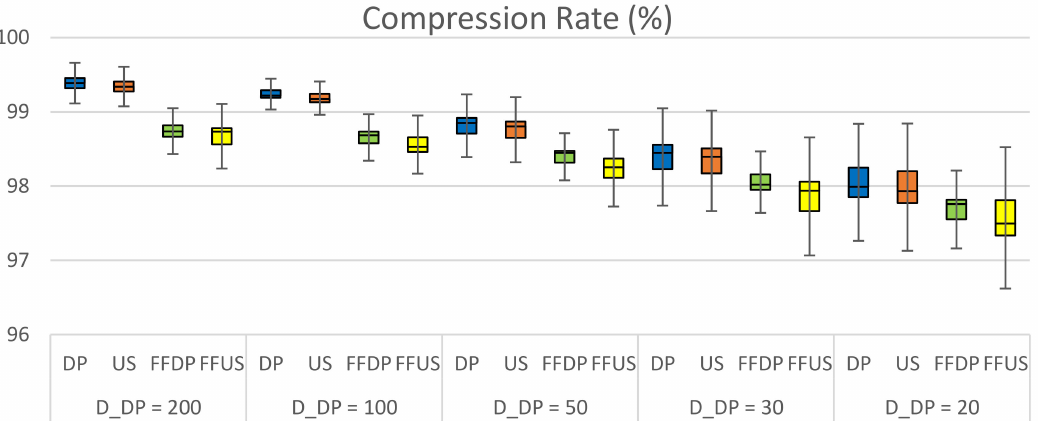
Figure 10. Performance comparison of US and FFUS.